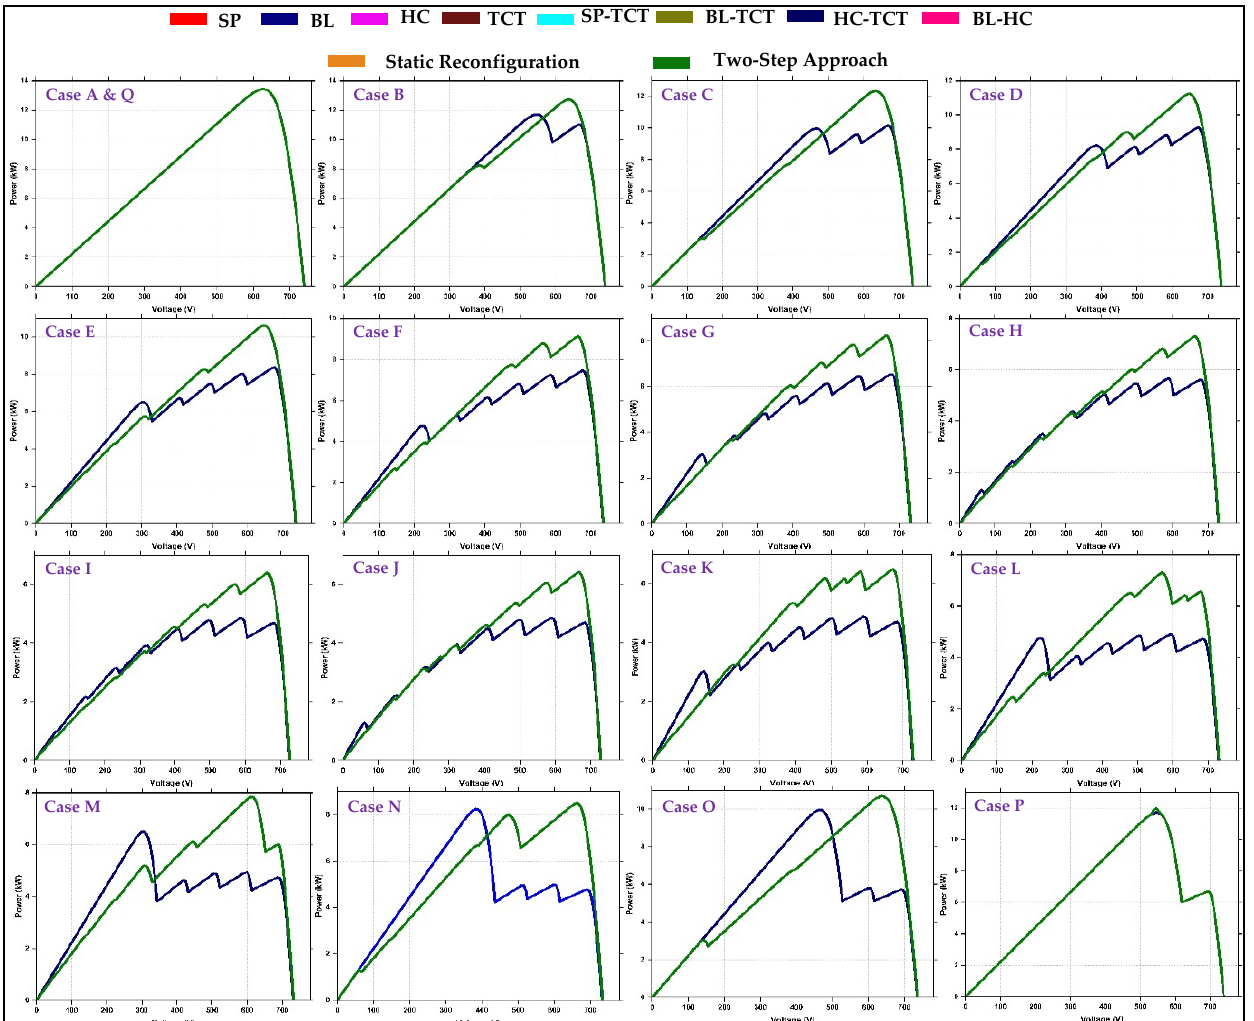
Figure 19. P~V curves for the partial shading cases in an 18 × 3 PV array with conventional and hybrid configurations using the two-step approach.